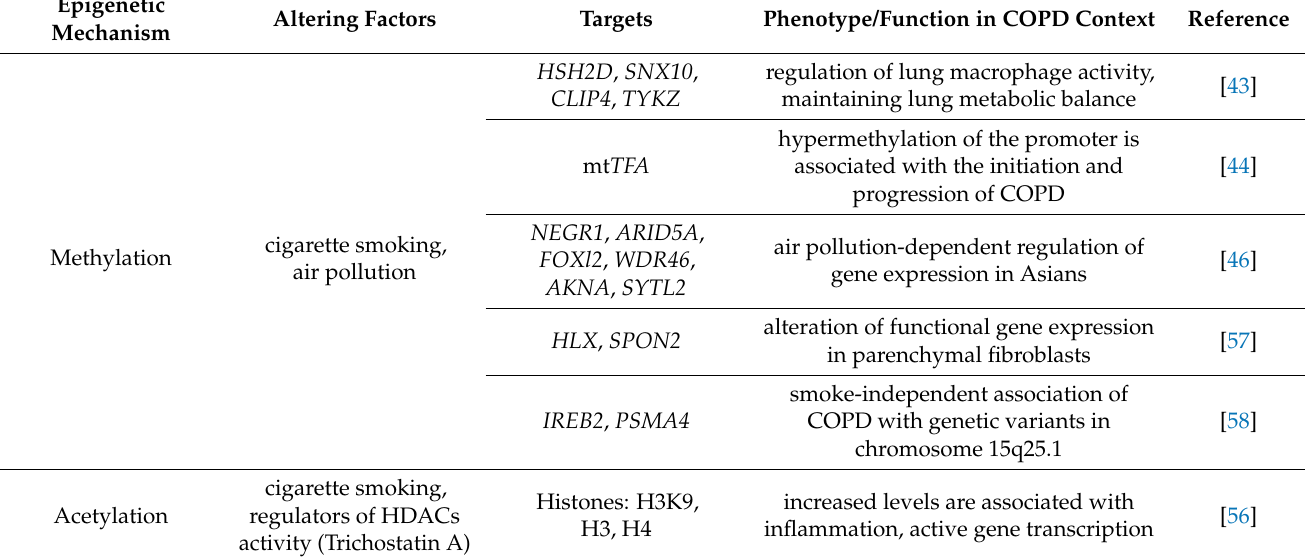
Table 2. Gene methylation and histone acetylation in